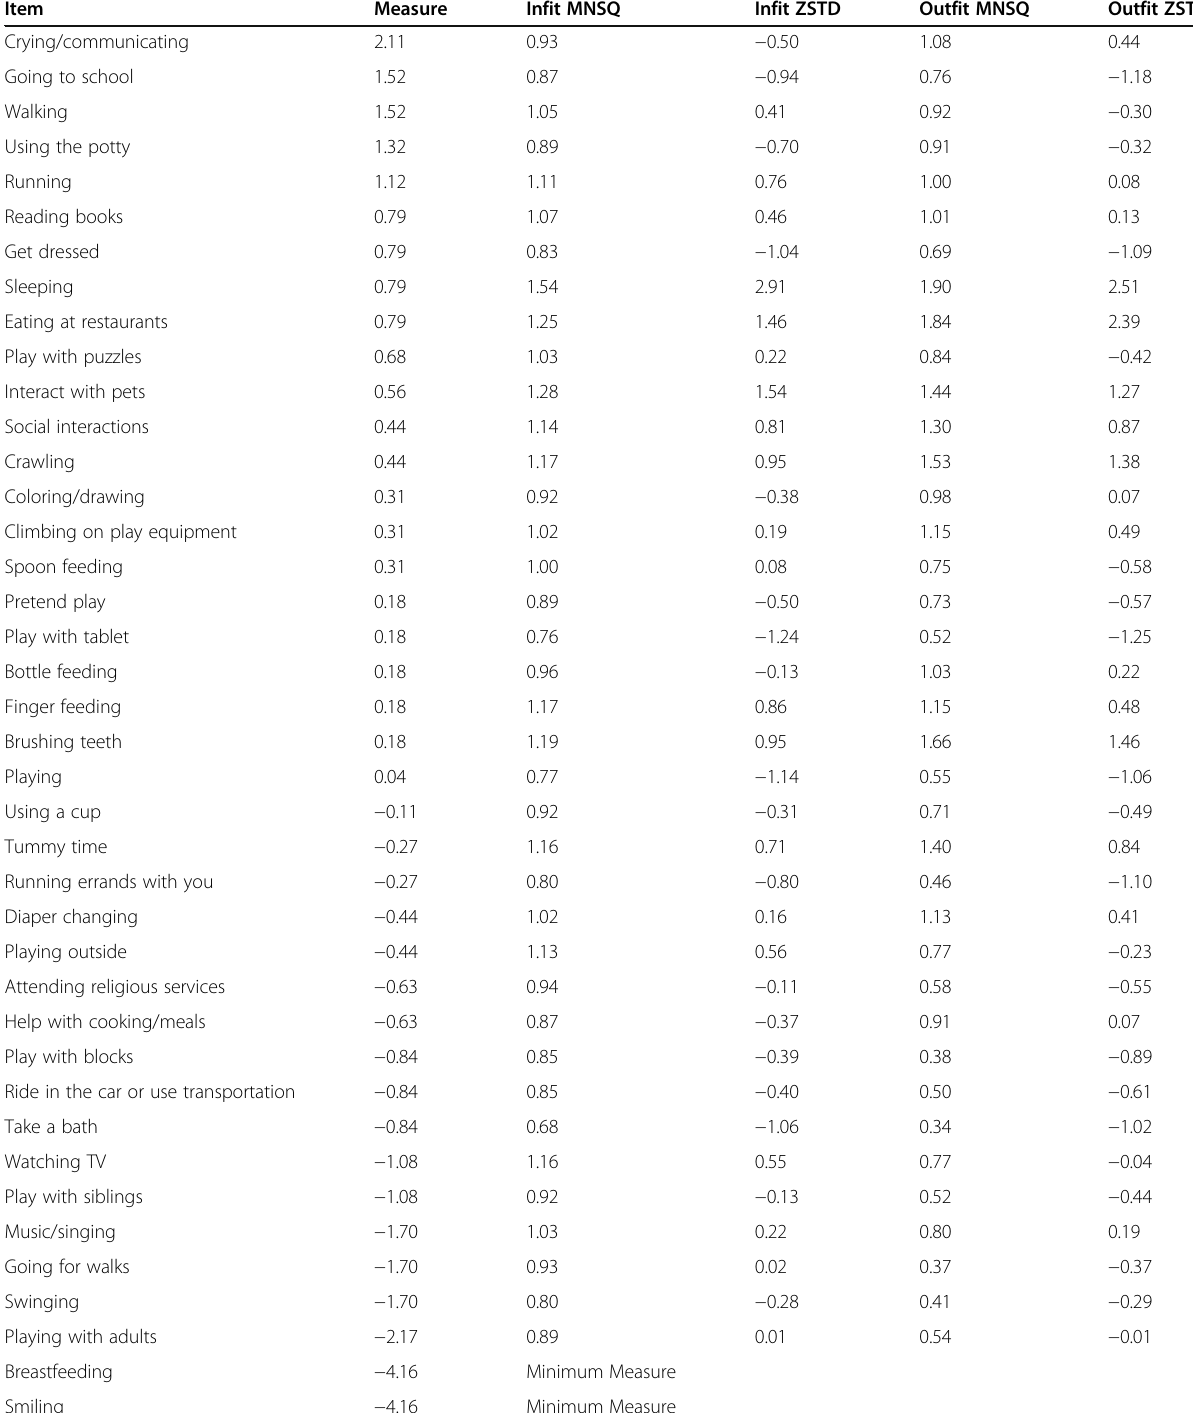
Reliability and separation Person and item reliability and separation statistics improved with each model iteration. Person (0.79) and item (0.80) reliability statistics were adequate (Table